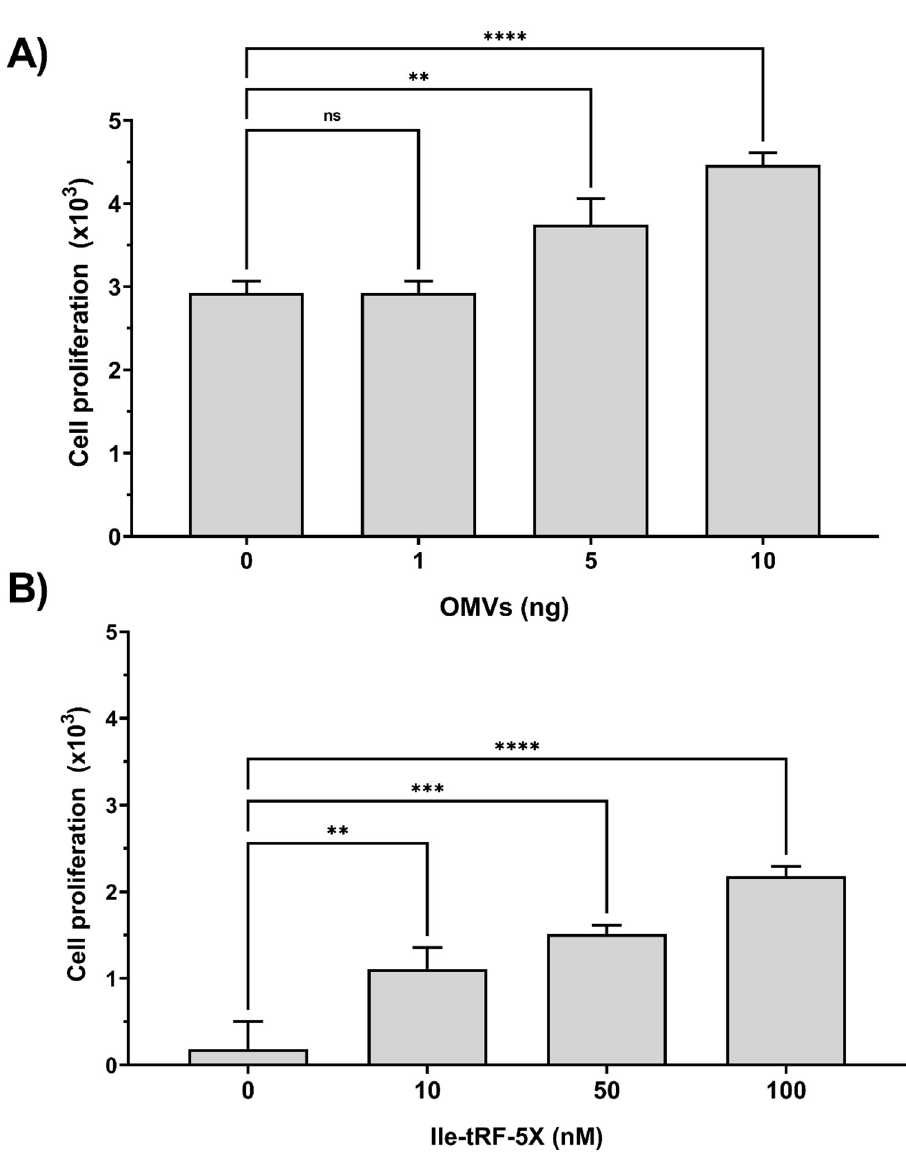
Fig 11. Bacterial OMVs and Ile-tRF-5X dose-dependently enhance human cell proliferation. ( A-B ) Human HCT116 cells were incubated with increasing amount of bacterial OMVs or transfected with increasing amount of Ile- tRF-5X. Cell proliferation was measured by plotting cell number from XTT-based absorbance (450 nm) measurements. Each dataset was normalized with its corresponding control (see materials and methods). Statistical analysis . Data were calculated from three biological replicate measurements (n = 3; mean ± SD), and each sample was tested in triplicate. One-way analysis of variance (ANOVA) and Holm-Sˇı´da´k’s multiple comparisons test (post-hoc test) was used for statistical analysis. Statistically significant differences (fold change vs. control) are indicated as follows: �� p < 0.01; ��� p < 0.001; ���� p < 0.0001. ns, not significant.